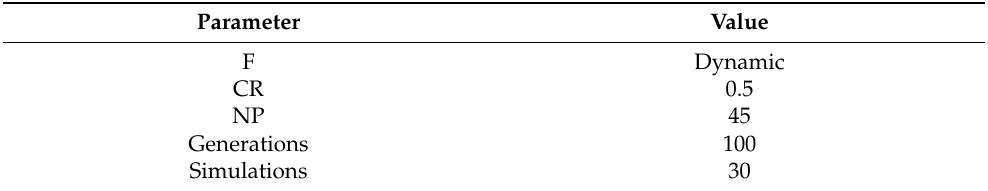
Table 5. IT3FDE parameter